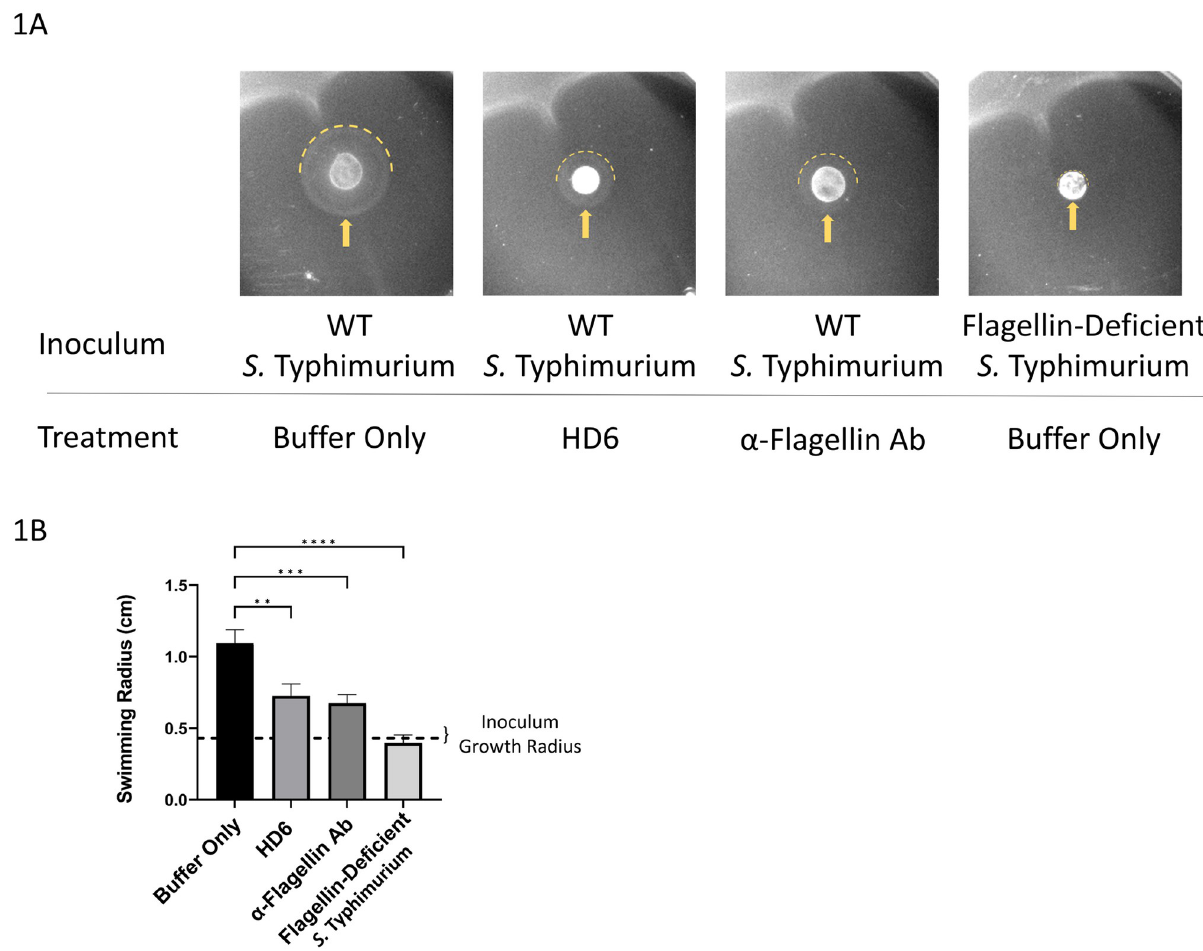
Fig 1. Analysis of HD6 effects on bacterial motility in semi-solid agar. ( A ) Images of semi-solid agar motility plates treated with either HD6 (30 μ g), α -FliC IgG antibody (20 μ g), or buffer (Tris-Maleate pH 6.4). Plates were then inoculated with either wild type (WT) S . Typhimurium or flagellin- deficient mutant, Δ fliC Δ fljB S . Typhimurium. After a 6.5-hour incubation at 37˚C, photographic images were captured. The outer edge of the bacterial swimming halo is highlighted by the dashed semicircular yellow line and yellow arrow. Images are representative of 2 independent experiments, each with technical replicates. ( B ) Quantification of the bacterial swimming halo radius for each experimental group as in (A). The dashed horizontal line represents the radius of the inner circle, representing the inoculum growth for non-swimming bacteria, averaged for all treatments. Error bars, mean ± SD. Data were pooled from 2 independent experiments, n = 6–13 plates, and analyzed using one-way ANOVA comparing experimental groups to buffer control ( �� P < 0.01, ��� P < 0.001, ���� P < 0.0001).